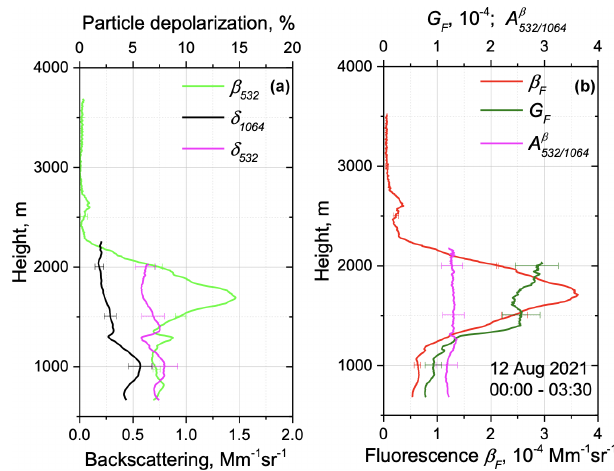
Figure 16. Vertical profiles of (a) backscattering coefficient β 532 and particle depolarization ratios δ 532 and δ 1064 . (b) Fluorescence backscattering β F , fluorescence capacity G F , and backscattering Ångström exponent A β on 12 August 2021 for the period 532 / 1064